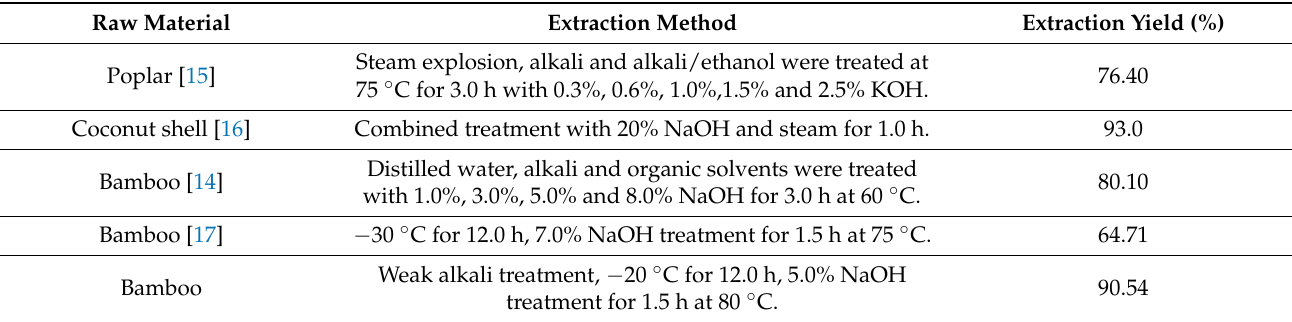
Table 1. Extraction yield of hemicellulose after different